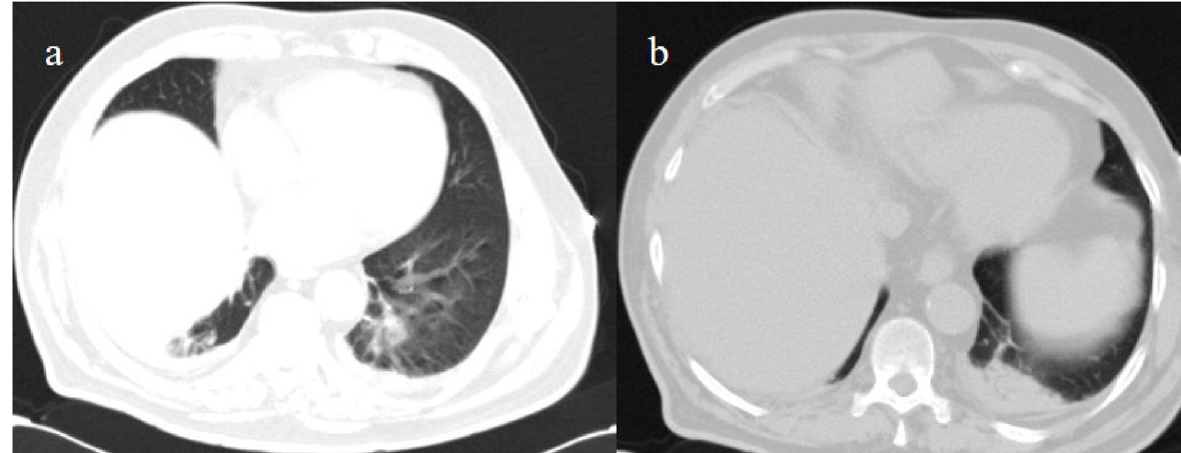
Figure 10. Some GGO and consolidation located at the peripheral and posterior inferior lobes, with some consolidation and small pleural effusion ( a , b ) were incidentally found on the chest CT performed on 7 July for thoracic pain in a patient who tested positive for SARS-CoV-2 and who came to the emergency room for a lipothymic